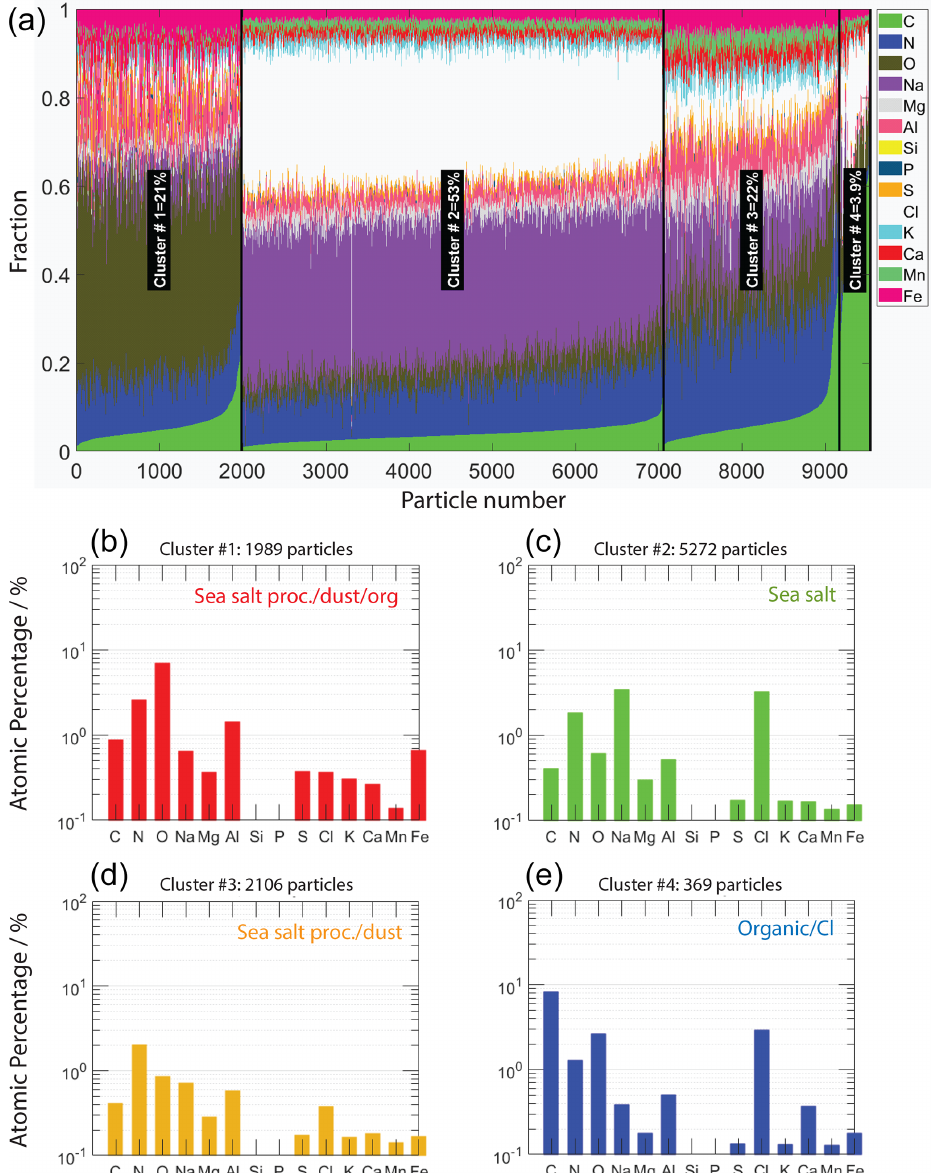
Figure 2. CCSEM/EDX-derived cluster analysis for identification of particle-type classes present in ACE-ENA particle samples. Panel (a) represents the cumulative atomic fraction of all analyzed particles. Panels (b–e) give detailed views of the cluster-averaged elemental compositions of the four particle-type classes identified by k -means cluster analysis. The representative particle types include “processed sea salt with mineral dust, sulfur, and organic matter”, “sea salt particles”, “processed sea salt with mineral dust”, and “organic matter–chlorine”- containing